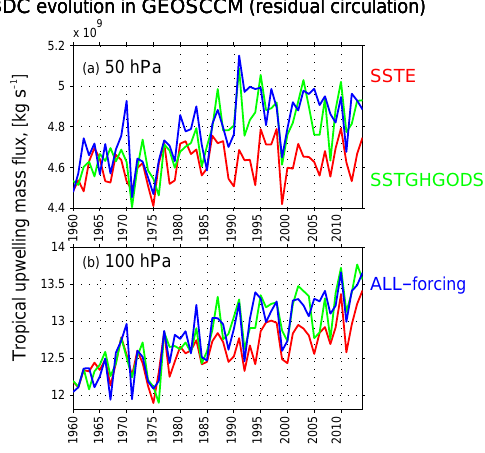
Figure 9. Time series of annual averaged mass flux between the turnaround latitudes at 50hPa (top) and 100hPa (bottom). Each line is for one ensemble mean. Blue is all forcing, red is SST only, and green is for SSTGHGODS. For clarity, we suppress two of the in- termediate